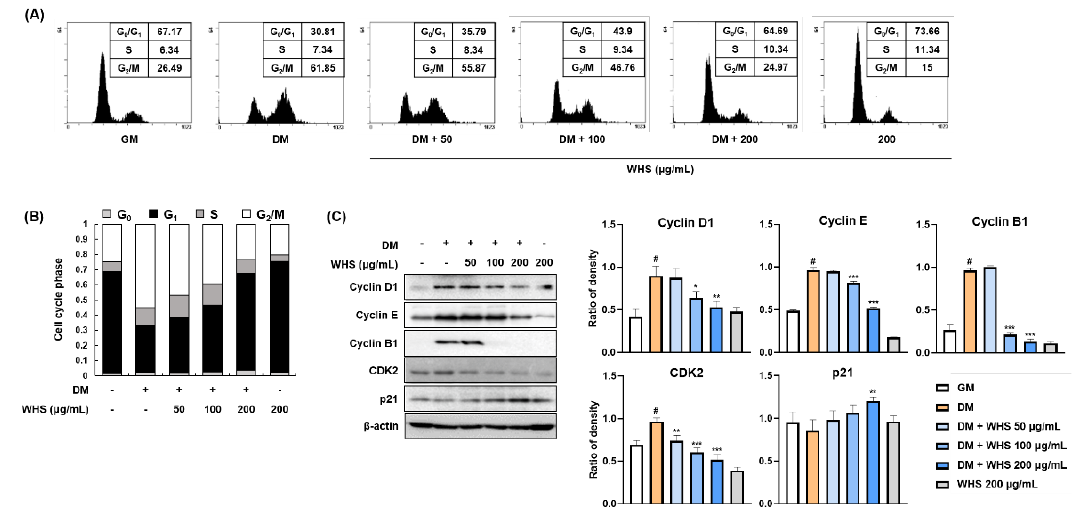
Figure 2. Inhibitory effect of WHS on the mitotic clonal expansion (MCE) in 3T3-L1 preadipocytes. ( A , B ) Flow cytometric analysis was performed to examine cell cycle progression. ( C ) The protein expression levels of cell cycle markers (cyclins, CDK2, and p21) were analyzed by western blotting. Values are expressed as the mean ± SD. # p < 0.05 vs. GM control group; * p < 0.05, ** p < 0.01, and *** p < 0.001 vs. DM control group.